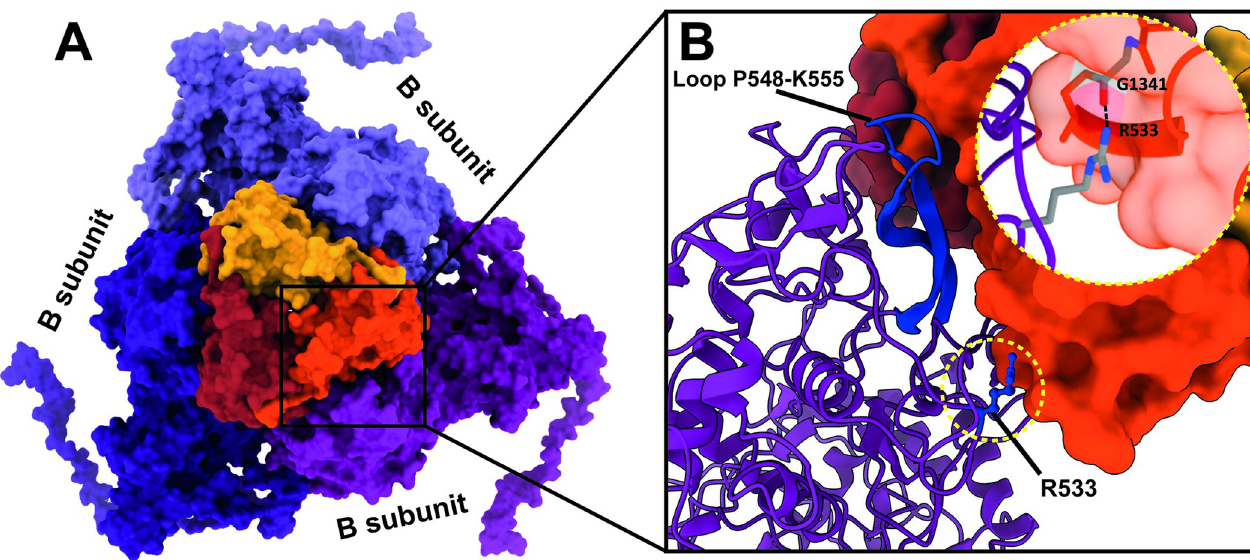
Fig 5. CrPs and their interactions with MCPs. A) Enlarged top view of the CrP trimer. Each trimer of the CrPs (red, orange, and dark yellow) is located on the top of the MCP_B subunits (purple, light purple, and dark purple) at the 3-fold axis. B) Close-up view of the interactions between CrP trimer and MCP_B subunit. The MCP_B subunit loop P548-K555 (dark blue) interacts with the CrP. The hydrogen bond between residues MCP_B subunit R533 and CrP G1341 is highlighted in a dashed-yellow circle.